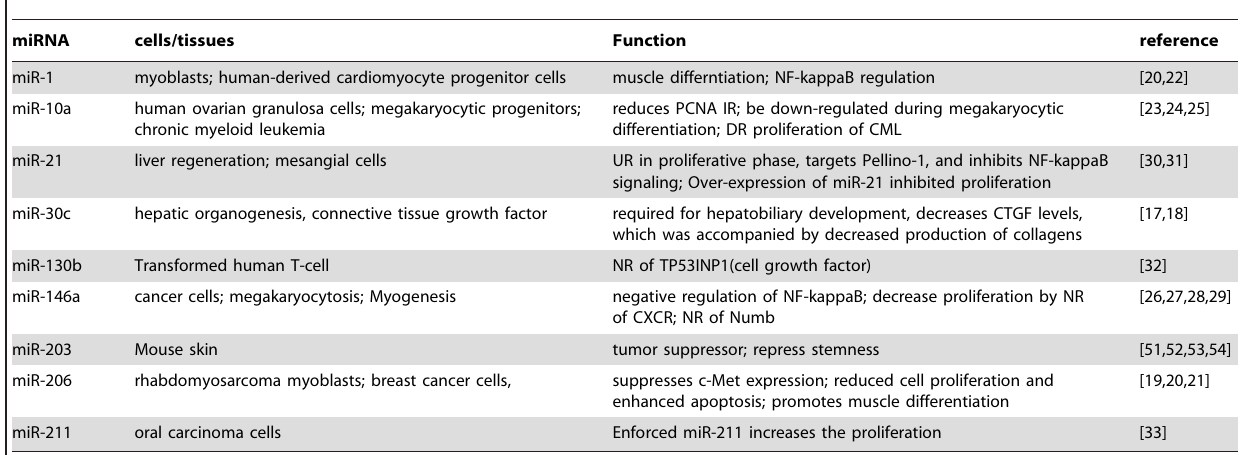
Table 2. Cell proliferation related miRNAs, which were regulated by miR-148a.